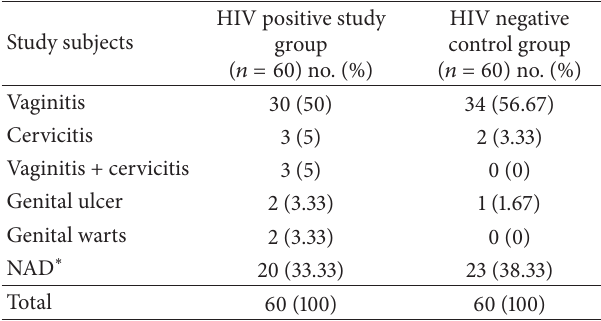
Table 4: STI/RTI syndromes among study subjects on the basis of per speculum examination ( 𝑁 = 120